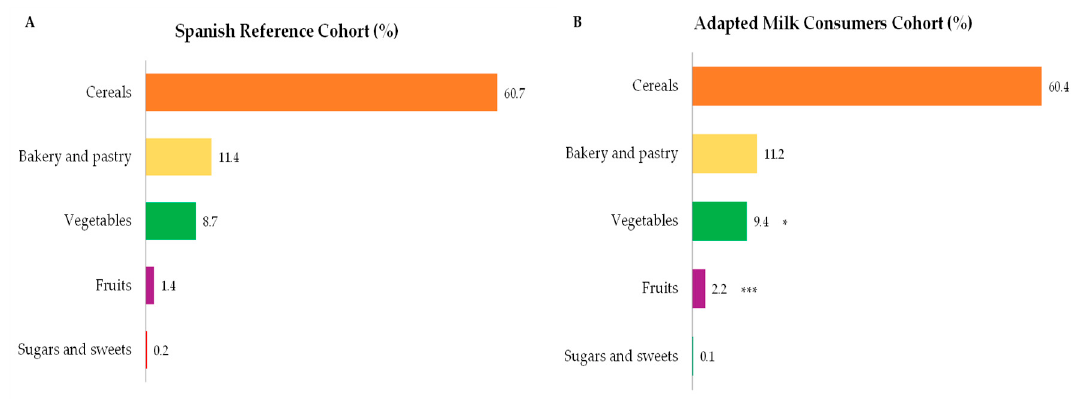
Figure 3. Dietary food and beverage groups contributing to total starch intakes (%) from the EsNuPI study population (“Spanish Pediatric Population”) in both reference cohort ( A ) and the Adapted Milk Consumers Cohort ( B ). * p ≤ 0.05 compared to reference cohort (Mann-Whitney test). *** p ≤ 0.001 compared to reference cohort (Mann-Whitney test). Only foods contributing ≥ 0.1% to total carbohydrates intakes of the population have been included.